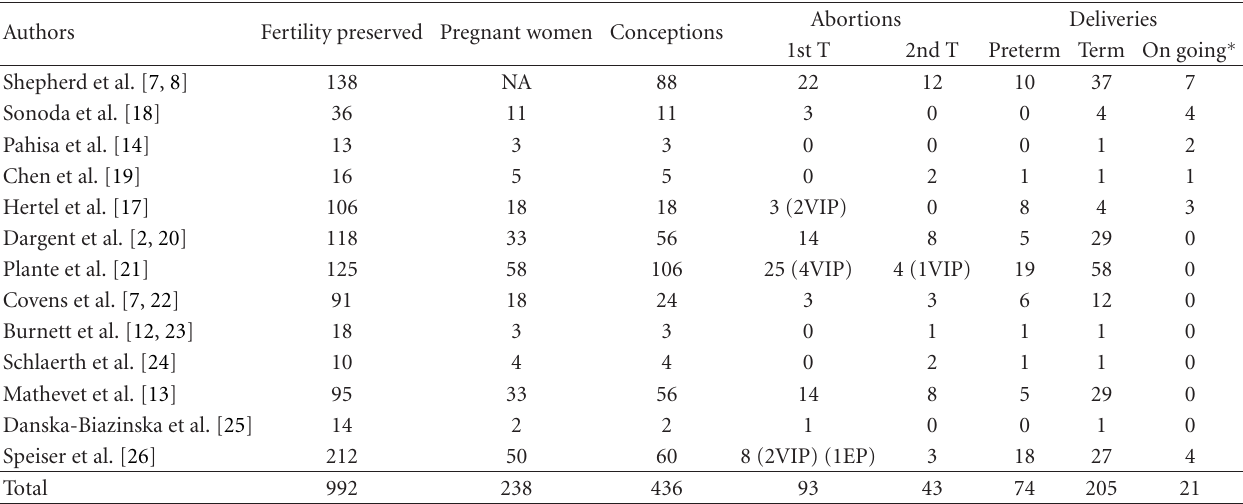
Table 3: Pregnancy outcomes of VRT.